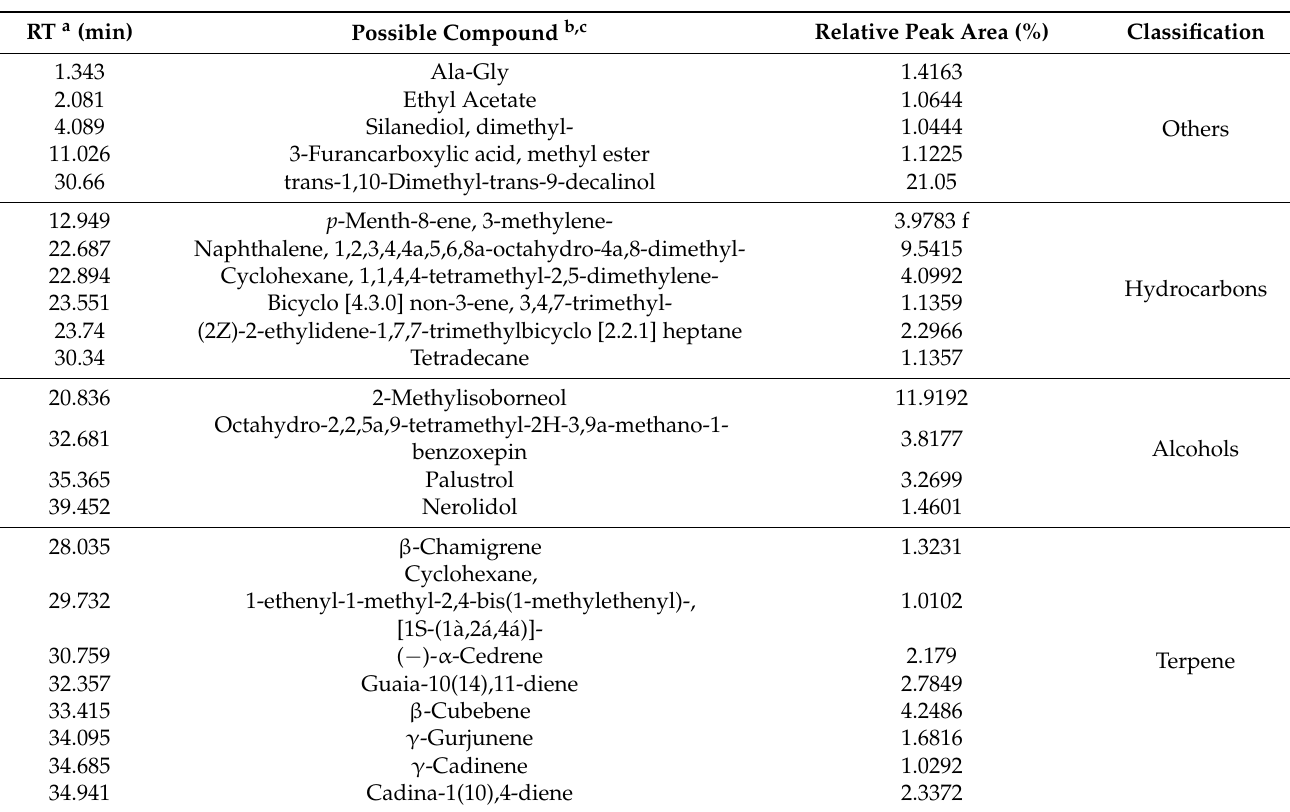
Table 1. VOCs produced by Streptomyces sp. Y1-14 by GC-MS